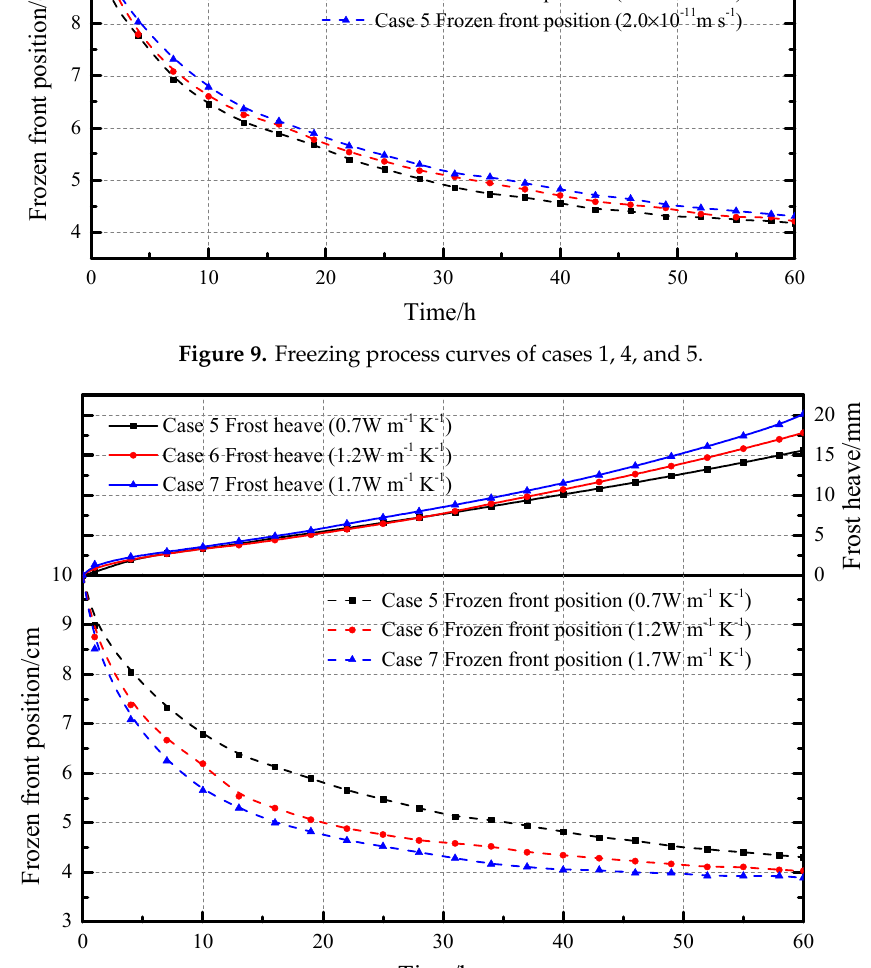
Figure 10. Freezing process curves of cases 5, 6, and 7.